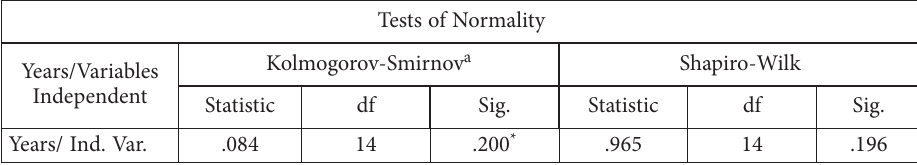
Table 3. Tests of normality Tests of Normality Kolmogorov-Smirnov a Shapiro-Wilk Years/Variables Independent Statistic df Sig. Statistic df Sig. Years/ Ind. Var. .084 14 .200 * .965 14